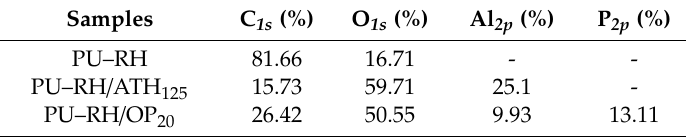
Figure 7. FE - SEM images of the residual chars of PU–RH, PU–RH/ATH 125 , and PU–RH/OP 20 after the Figure 7. FE-SEM images of the residual chars of PU–RH, PU–RH / ATH 125 , and PU–RH / OP 20 after the cone calorimetry test. cone calorimetry